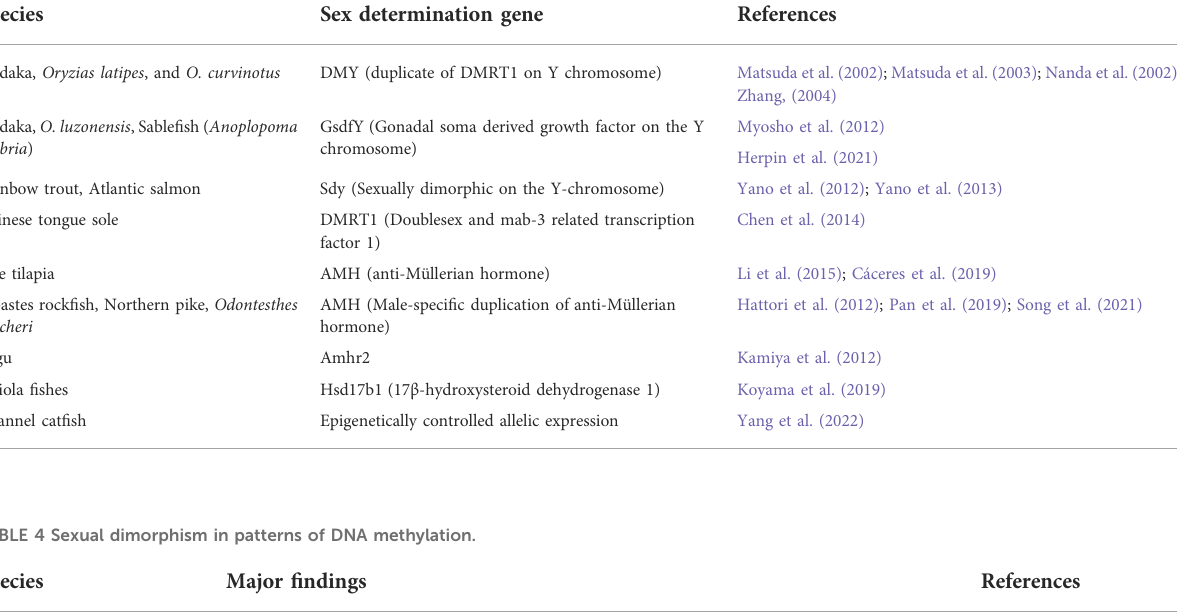
TABLE 3 Sex determination genes in selected fi sh species.